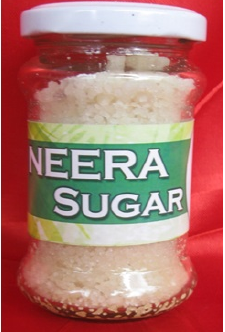
Figure 7. Coconut Neera sugar prepared from the concentrate.